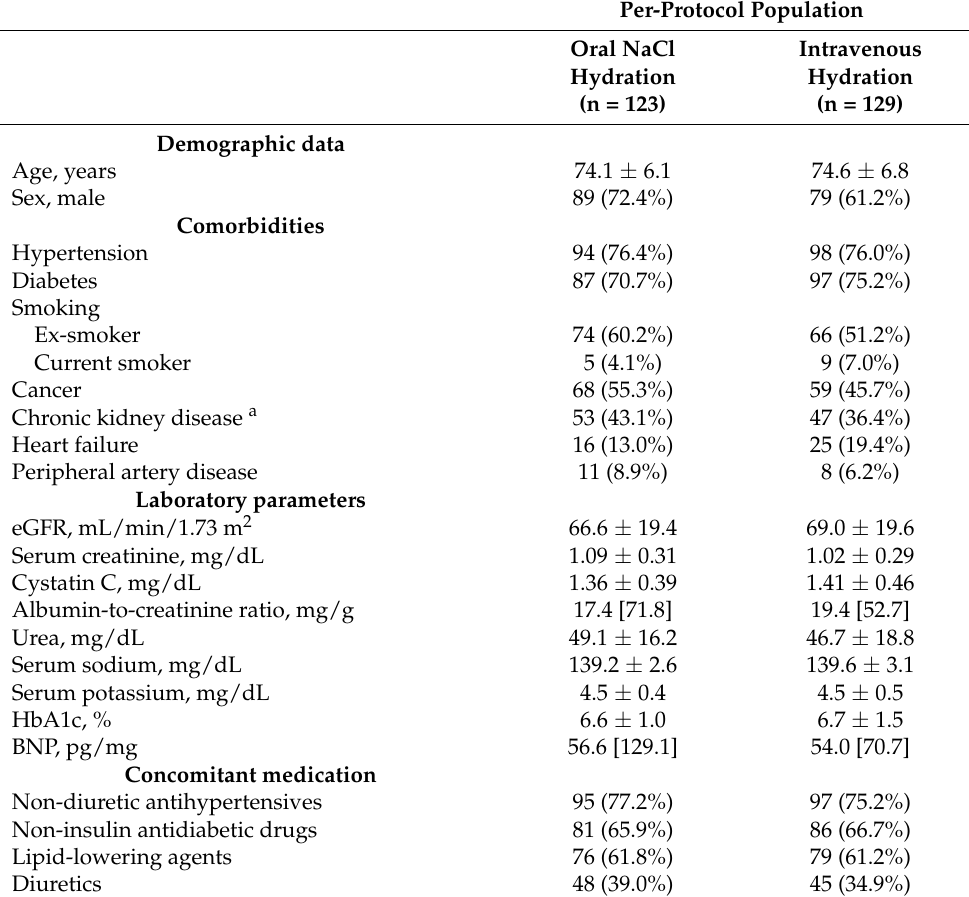
Table 1. Patient characteristics at inclusion in the study (per-protocol